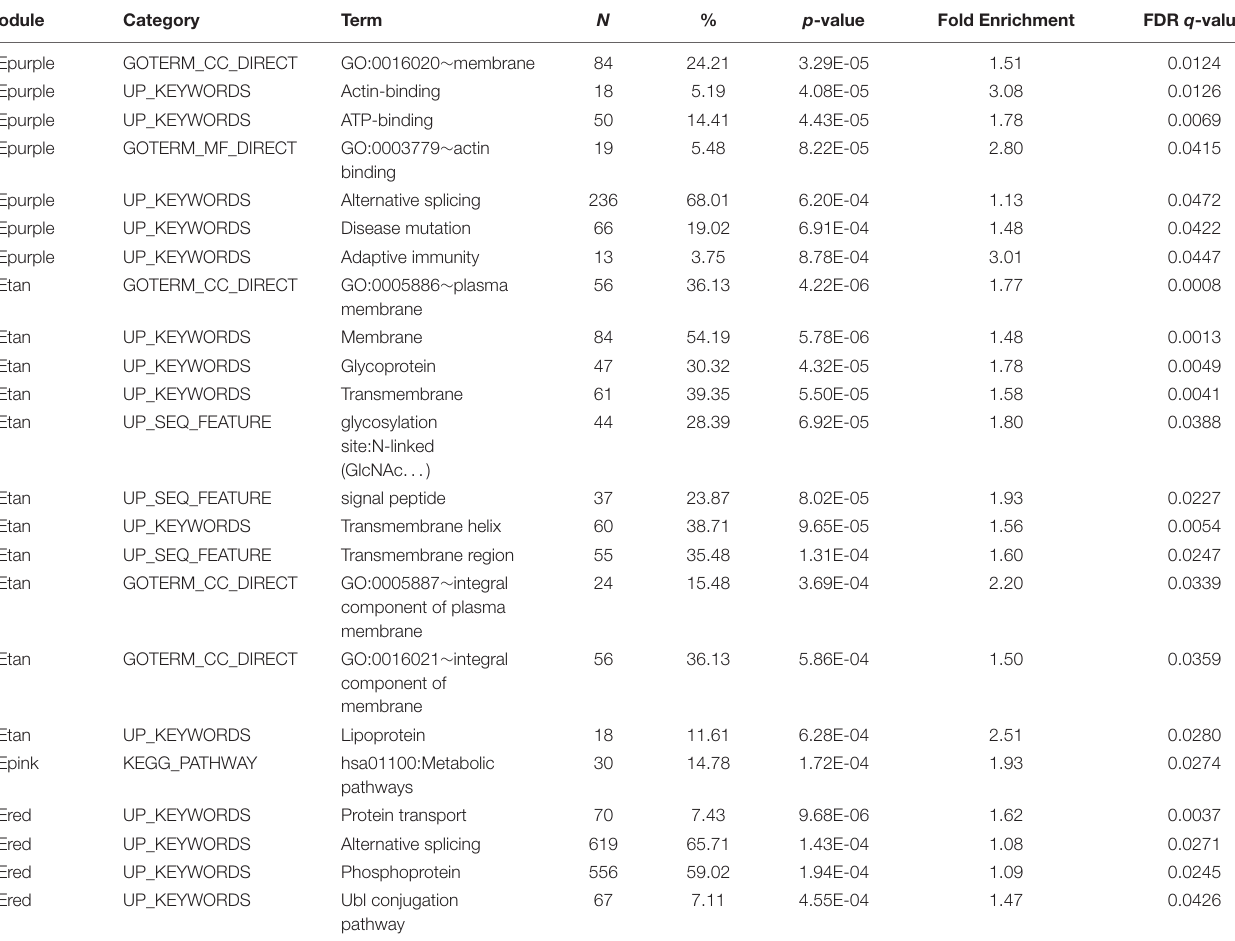
TABLE 3 | Pathways enriched in co-expression modules that are also associated with PTSD (MEpurple, MEtan, MEpink, and MEred).